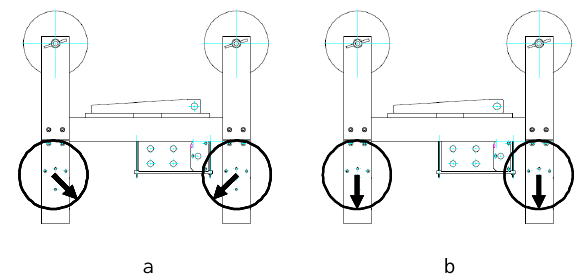
Figure 2. Image acquisition geometry: a) convergent, b) parallel.